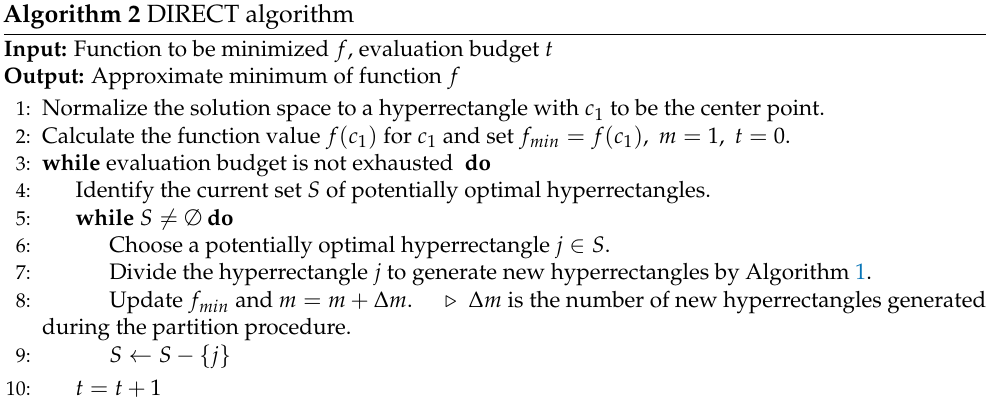
Algorithm 2 DIRECT algorithm